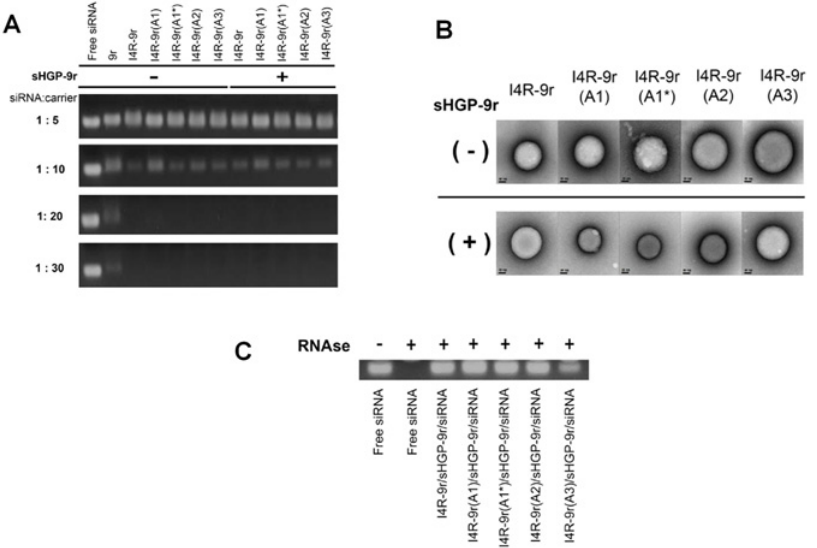
Fig 3. Physicochemical characterization of I4R-9r variants PwSNs. (A) siRNA encapsulations by I4R-9r variants were monitored by gel retardation assay with molar ratios of 1:5 to 1:30 (siRNA: carrier) in the presence and absence of sHGP-9r. (B) Representative TEM of an I4R-9r tandem peptide variants/siRNA nanocomplex formed in water in the presence and absence of sHGP-9r; scale bar = 50 nm. (C) Stability of I4R-9r variant/sHGP-9r/siRNA nanocomplex was examined in the presence of RNase A. Undegraded siRNA of the nanocomplex was visualized on 2% agarose gel containing EtBr. The stability of free siRNA was measured as